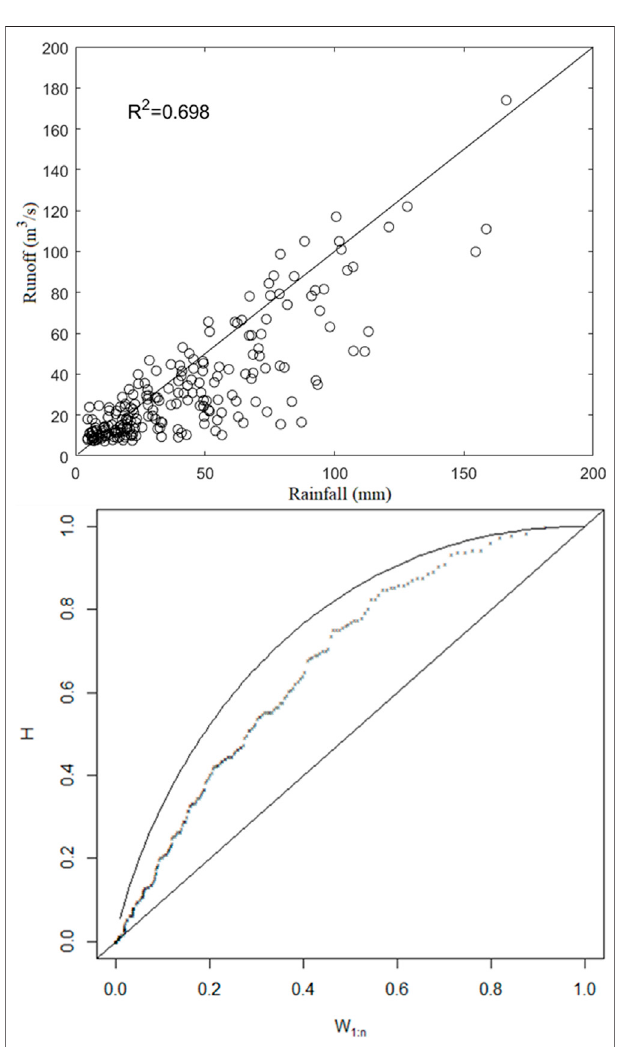
FIGURE 5 | The Scatter plot and Kendall plot of monthly rainfall and runoff. The top one is Scatter plot and the bottom one is Kendall plot.